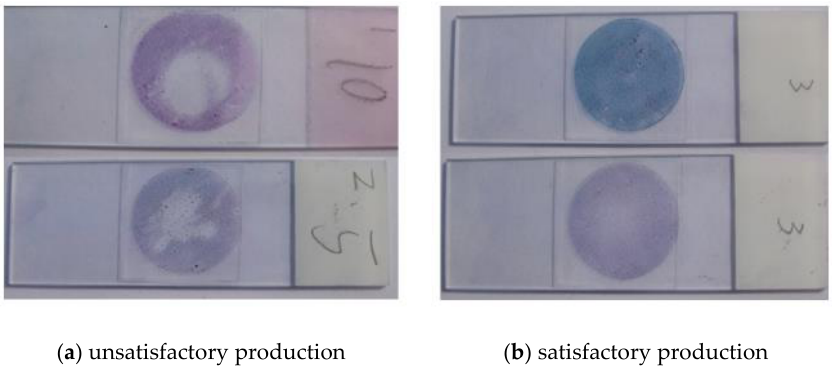
Figure 11. Comparison of film production with the visual observation.